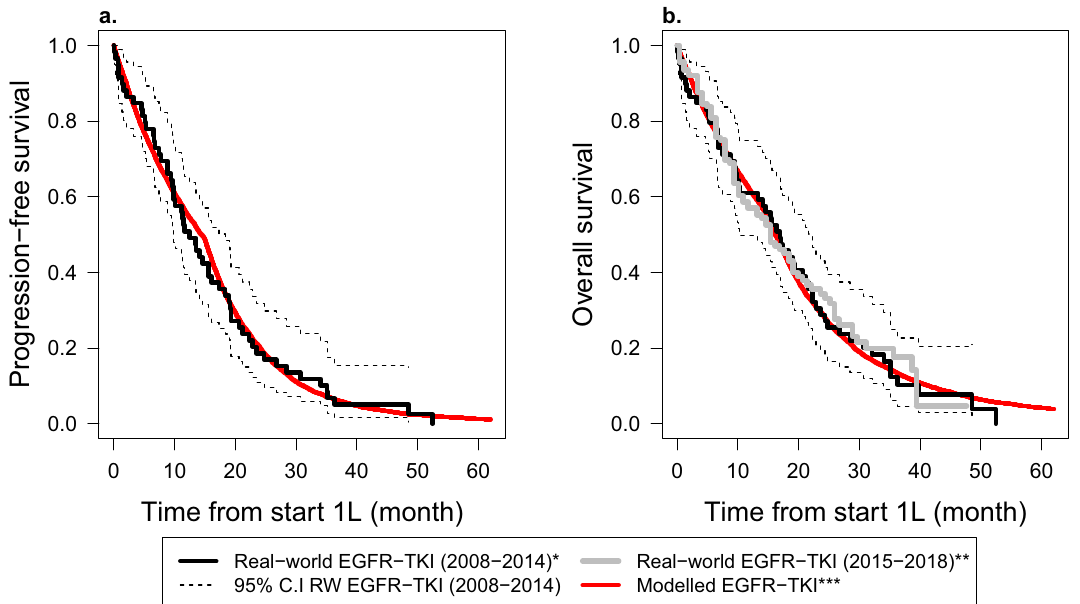
Figure 4. Comparison of modelled and real-world progression-free survival ( a ) and overall survival ( b ) curves for patients with epidermal growth factor receptor (EGFR) mutations and treated with a first-line EGFR tyrosine kinase inhibitors (EGFR-TKIs). EGFR-TKI were gefitinib or erlotinib; C.I, confidence interval; RW, Real-world; 1L, first-line systemic treatment. *The real-world data of 52 patients diagnosed and treated between 2008 and 2014 in Santeon hospitals 42 . **The reconstructed (digitized) real-world overall survival (OS) data of 147 patients treated between 2015 and 2018 in Santeon hospitals. The OS data were digitized from the curve published by Cramer-van der Welle et al., 2021 19 . Progression-free survival (PFS) data was not available. ***Modelled data was simulated assuming the hazard ratios of 0.43 and 0.36 for gefitinib and erlotinib compared to chemotherapy, respectively 39 , and hazard ratio of 0.82 for prognostic value of EGFR positive compared to EGFR negative 40 . EGFR-TKI benefit was assumed to wear out after 15